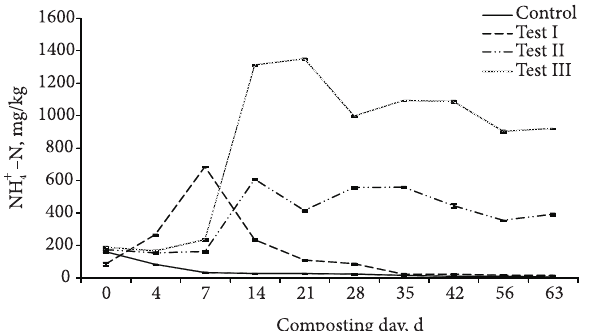
Fig. 6. The NH 4+ -N profile during composting